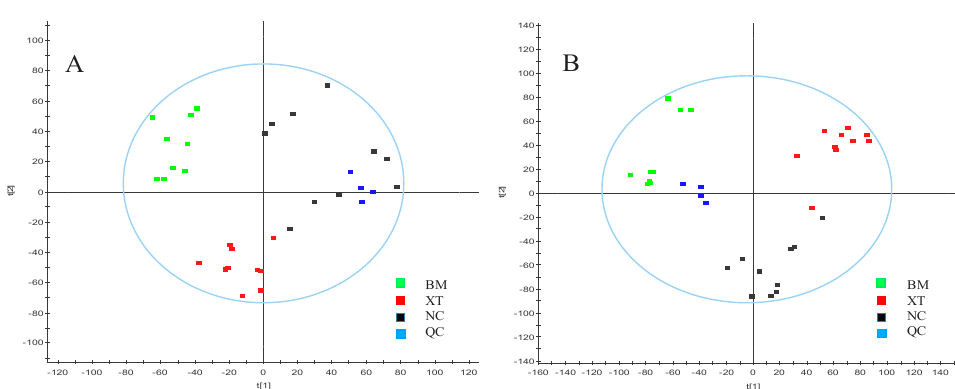
Figure 2. PCA score plots of urine metabolic profiling of NC, BM, XT and QC in positive mode ( A ) and negative mode ( B ).